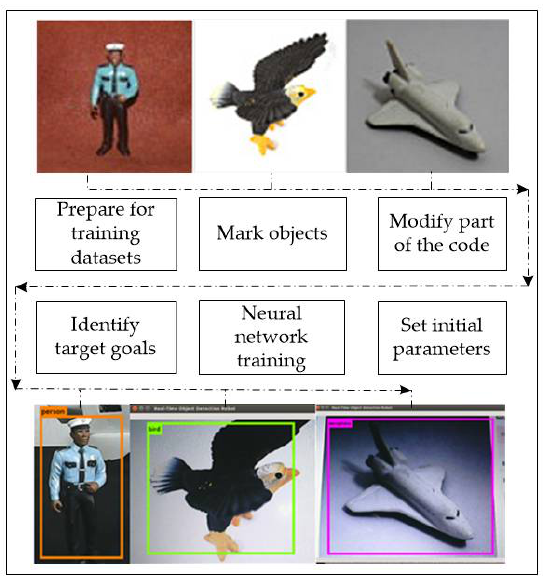
Figure 7. Detection of the target object.